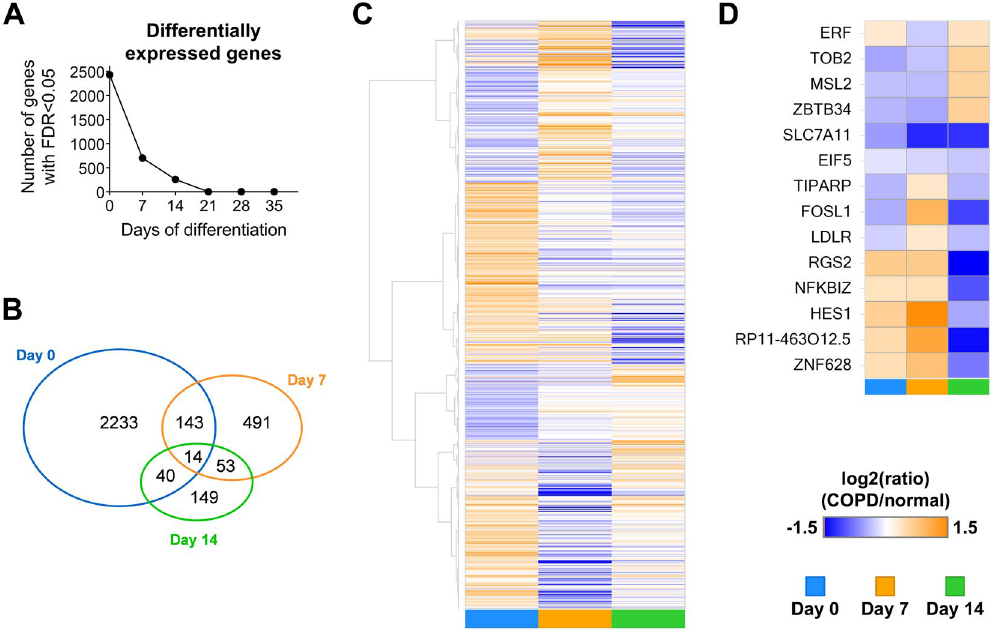
Figure 5. Differential gene expression in primary normal human bronchial epithelial cells differentiated on COPD compared to normal bronchial scaffolds. ( A ) The number of differentially expressed genes in cells on COPD compared to normal bronchial scaffolds at each time point during differentiation. ( B ) The number and overlap of differentially expressed genes on day 0, 7 and 14. ( C ) Heatmap showing hierarchically clustered log 2 (ratio) data where the ratio is defined as mRNA expression level in cells on COPD relative to normal scaffolds. Data are shown for all genes differentially expressed at one or more of the first three time points of differentiation. ( D ) Heatmap showing log 2 (ratio) data for the 14 genes differentially expressed at all of the first three time points. All data in this figure represent n =